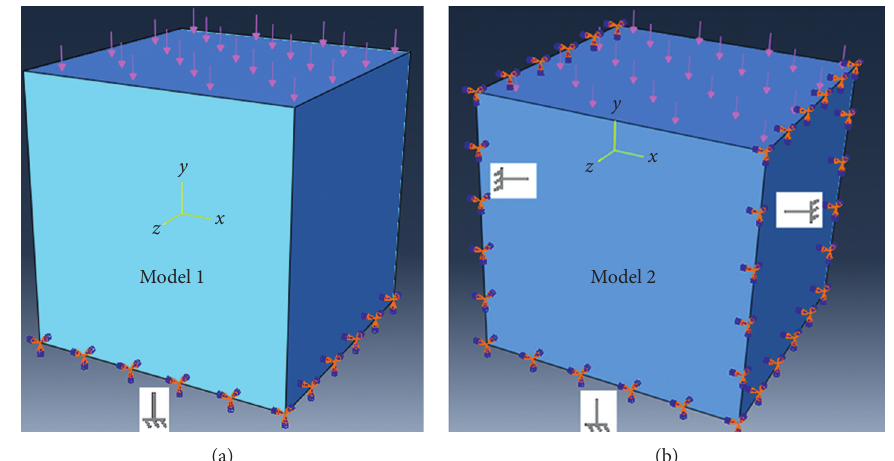
Figure 3: Loads and constraints used in model one (a) and two (b).